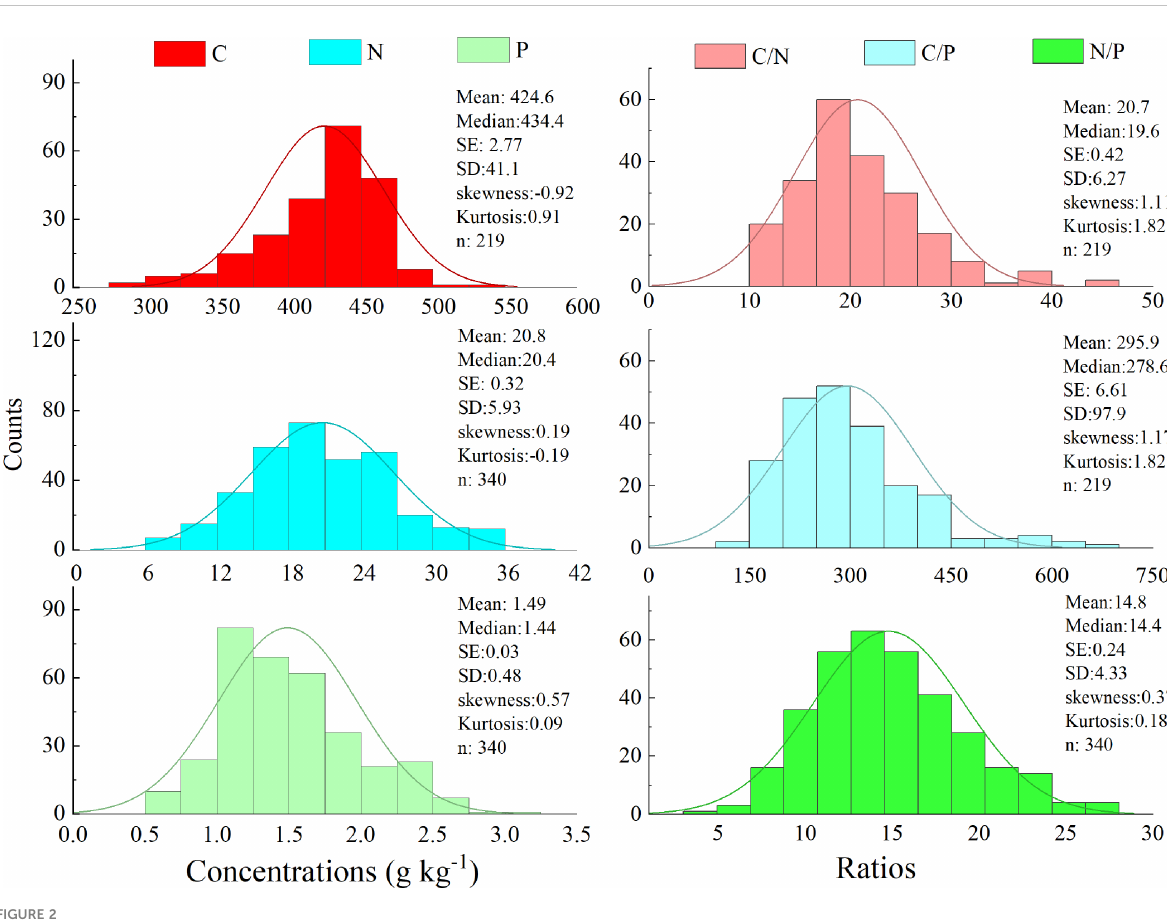
FIGURE 2 Frequency of the foliar C, N, and P stoichiometry in study